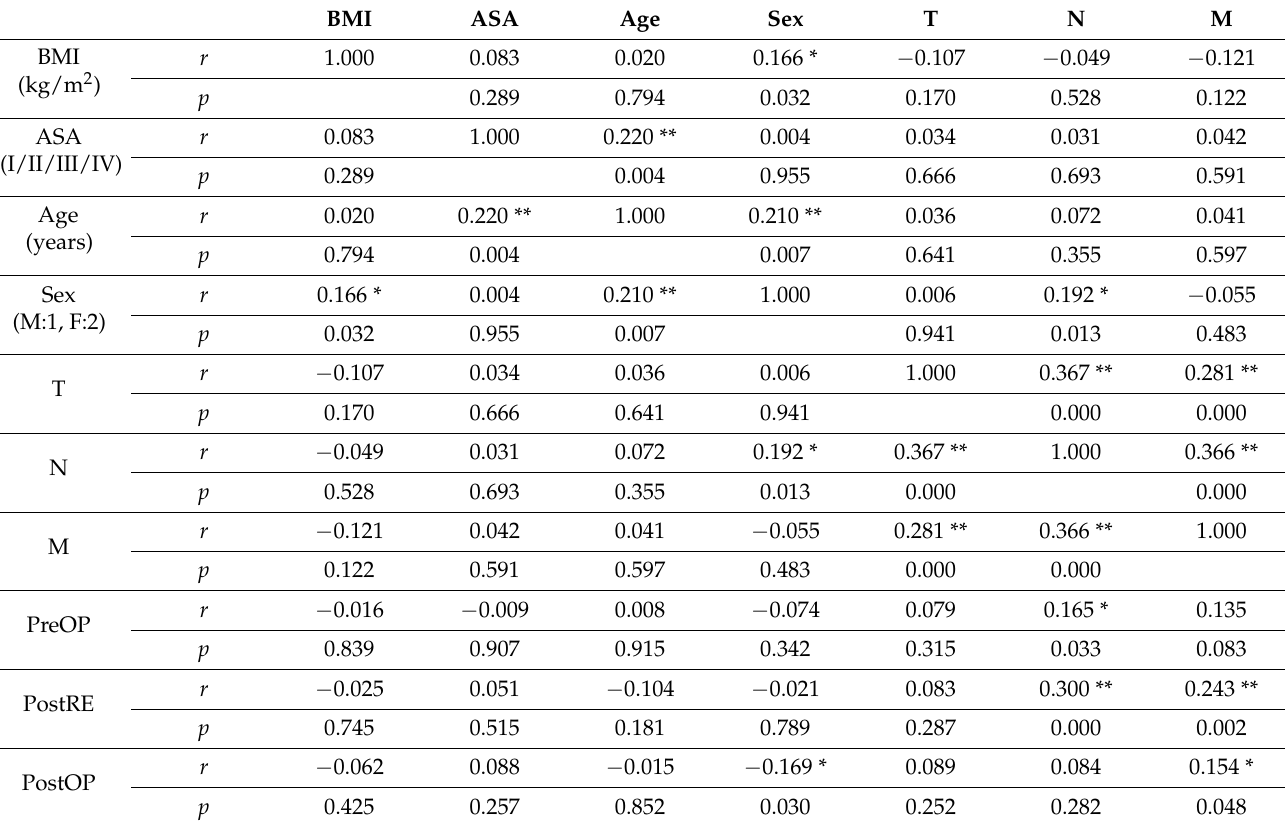
Table 3. Correlation analysis of overall patients (Spearman’s